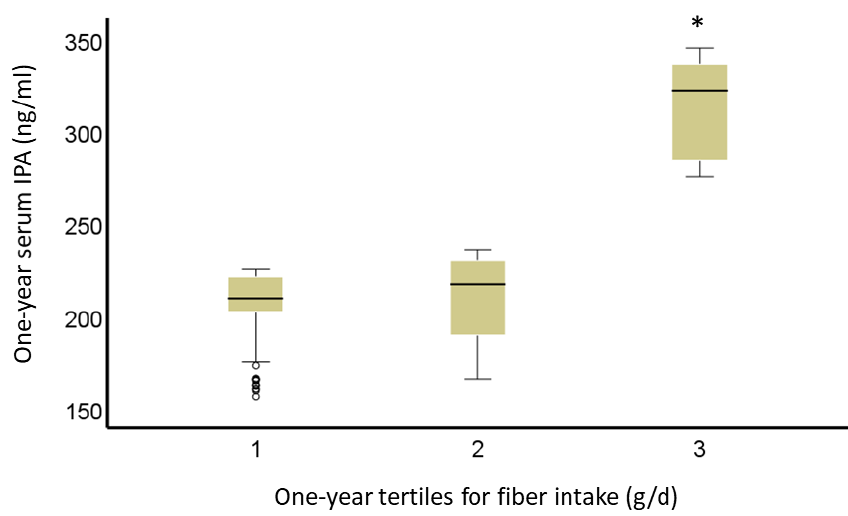
Figure 5. Serum IPA (ng/mL) by tertiles of fiber intake (g/d) at year 1 in the DPS. * Represents p -value < 0.05 vs. 3rd. The bars represent the estimated marginal means, and the whiskers are confidence intervals (95%).